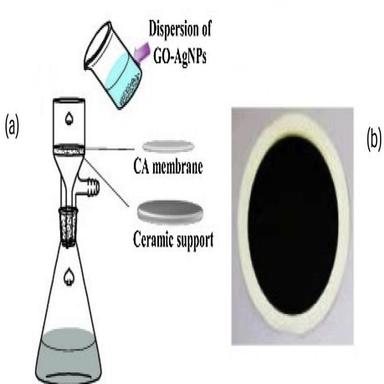
(a) Vacuum filtration process to produce membrane. (b) Photo of the membrane obtained.